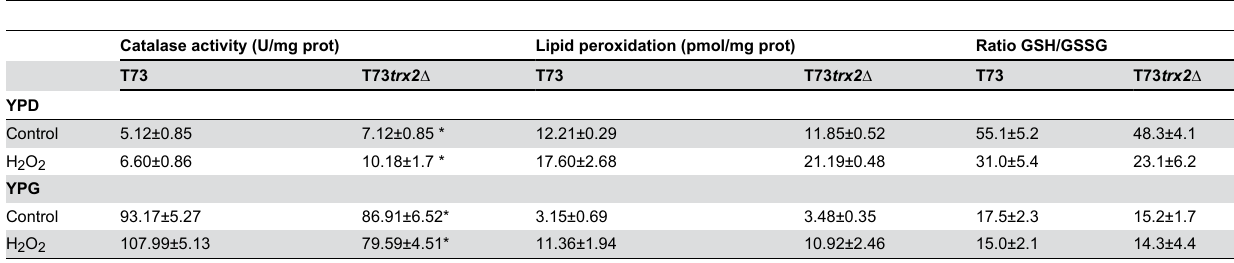
Experiments were carried out in triplicate and presented error corresponds to SD. Statistical analyses were performed using a Student´s t-test between samples in the same growth media, YPD or YPG (* p< 0.05).